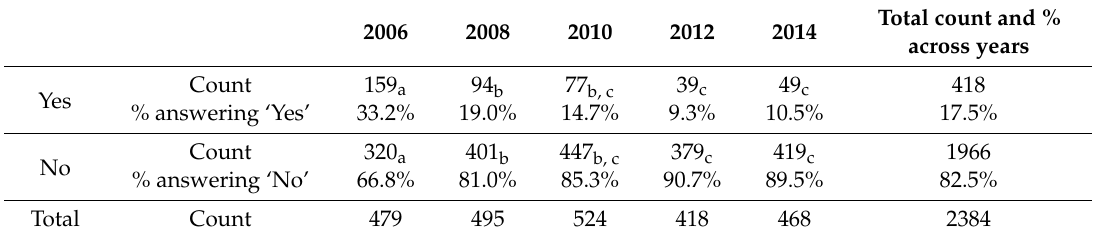
Total count and % across years